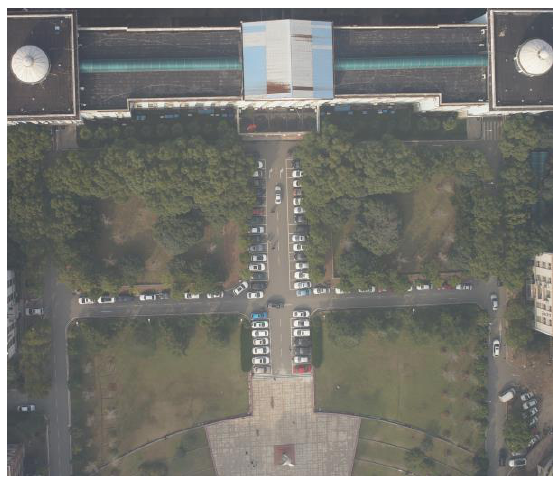
Figure 3.UAV image of the outdoor experimental